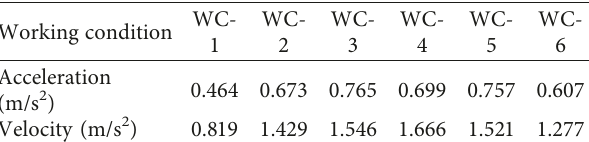
Table 6: Peak acceleration and peak velocity in the X